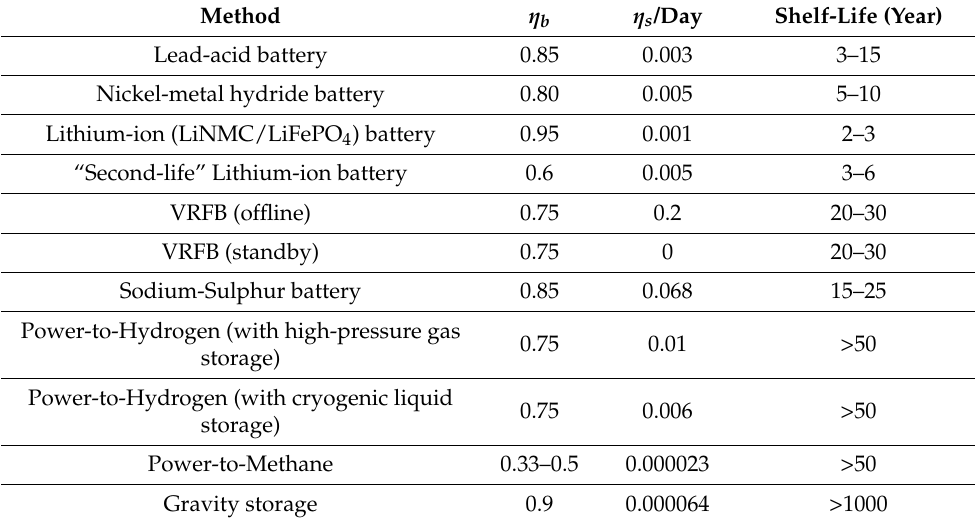
Table 1. Constants of the simplified (linear) ADSF ( t ) function (Equation (3)). The values shown are for the best commercially available models for the type; some manufacturers’ products may perform better or worse than this. Limits for these values are shown in Supplementary Materials Table